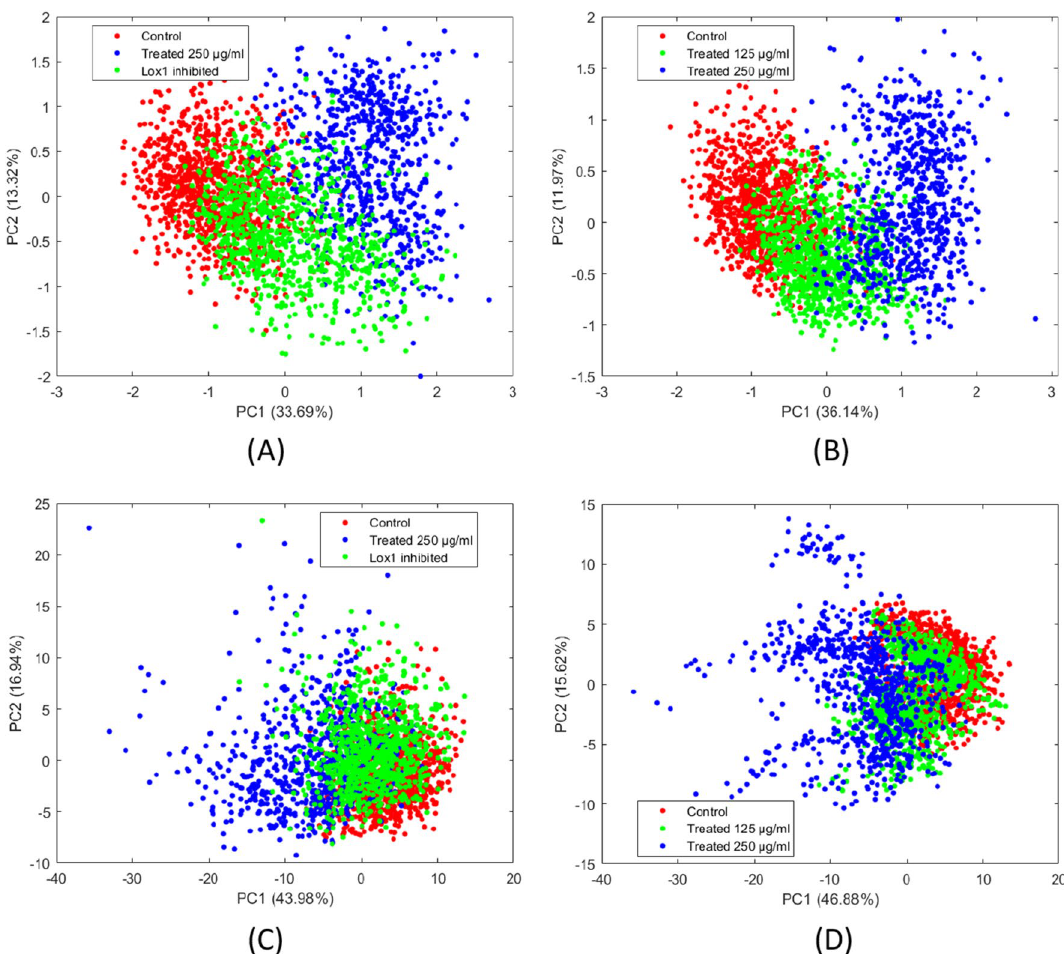
Figure 5. PCA Scores plot of the first two components obtained using: ( A ) Deep Features—Control DLD-1 (red) versus treated at 250 μg/ml (blue) versus LOX1 inhibited (green). ( B ) Deep Features—Control DLD-1 cells (red) versus treated at 125 μg/ml (green) versus treated at 250 μg/ml (blue). ( C ) Traditional features—Control DLD-1 (red) versus treated at 250 μg/ml (blue) versus LOX1 inhibited (green). ( D ) Traditional features— Control DLD-1 cells (red) versus treated at 125 μg/ml (green) versus treated at 250 μg/ml